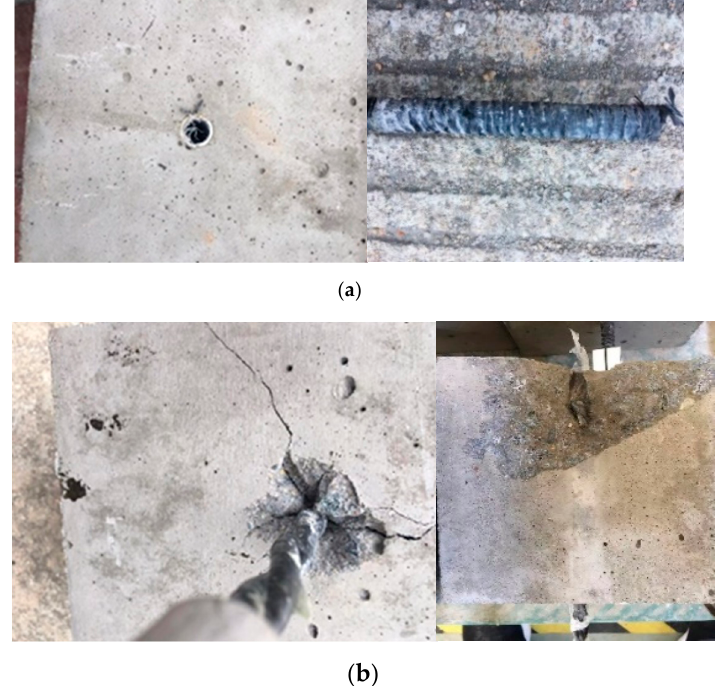
Figure 5. Different types of failure mode: ( a ) CFRP bar pull-out failure; ( b ) concrete splitting fail- ure.